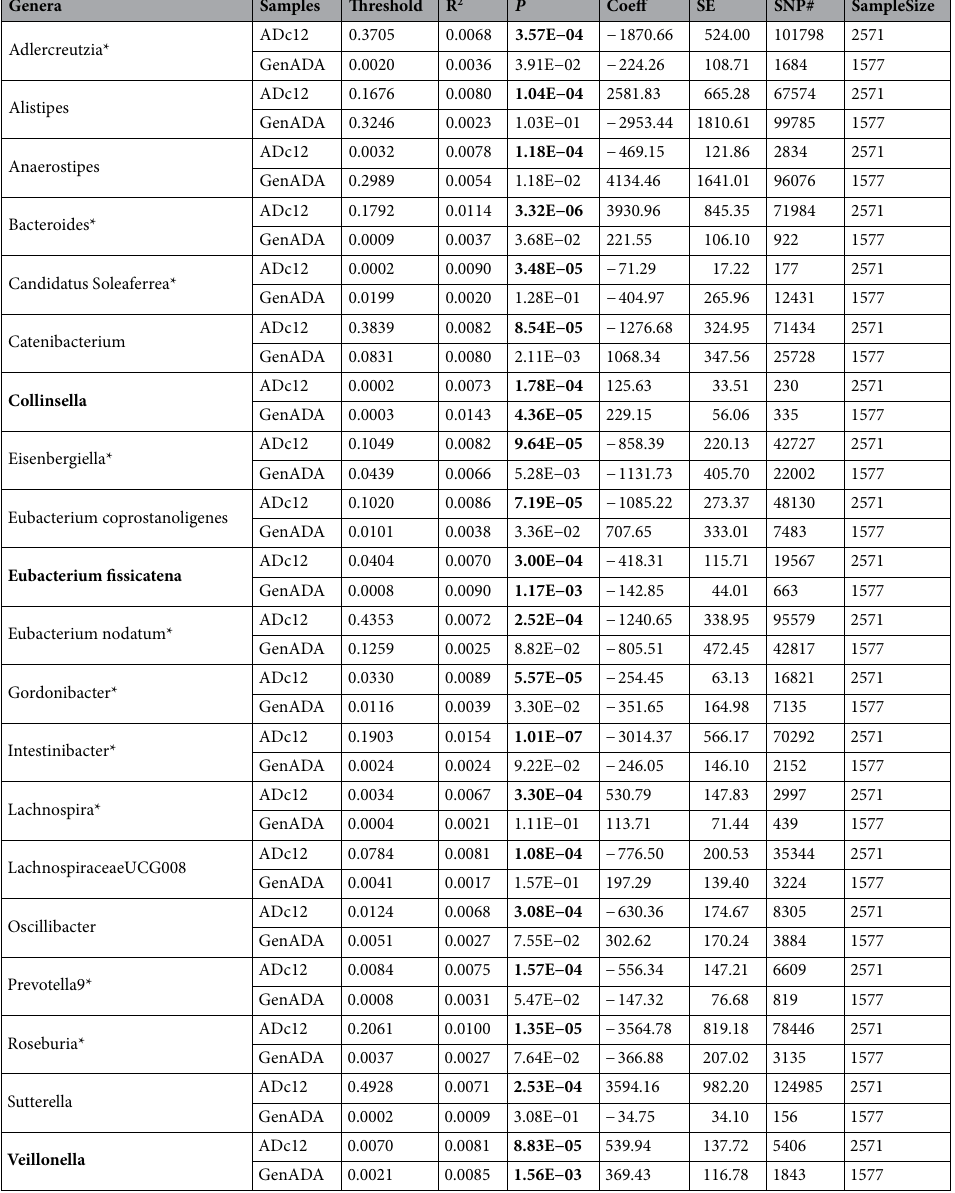
Table 3. Association between significant microbiome genera and AD diagnosis from “best-fit” PRSice-2 model. Genetic association between PRSs for top 20 microbiome genera and AD diagnosis from PRSice-2 “best-fit” model. The association from the “best-fit” threshold was generated from PRSice-2 with a range of p -value thresholds from 5 × 10 −8 to 1 and incremental interval of 5 × 10 −5 ; R 2 : Variance explained by the PRS model; P : p -value of model fit for the association; Coeff: Coefficient of the model; SE: standard error; # of SNPs: Number of SNPs included in the model at the specified threshold. Genera in bold are three genera